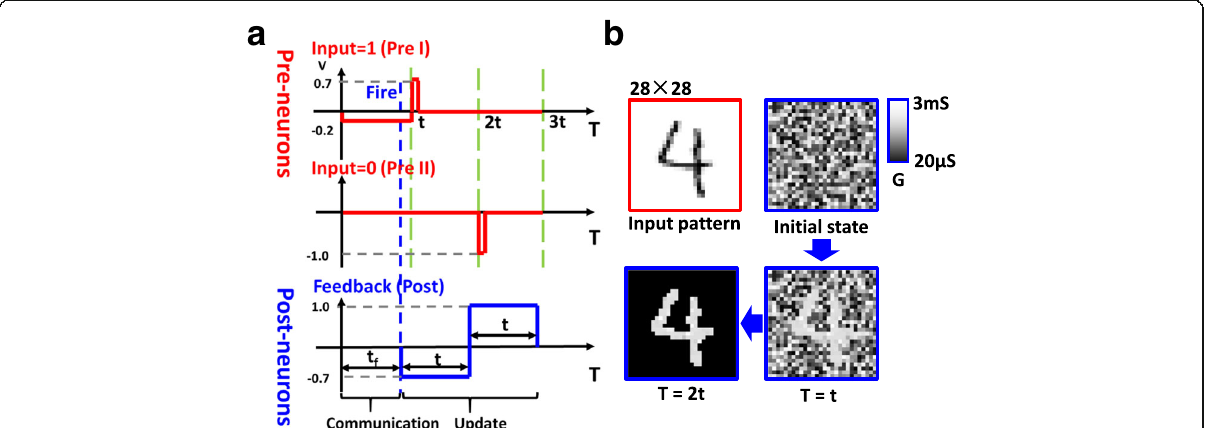
Fig. 6 One learning epoch. a Waveforms used for the learning epoch, including pre I, pre II and post, which correspond to input information 0, 1, and feedback signal. Parameter t